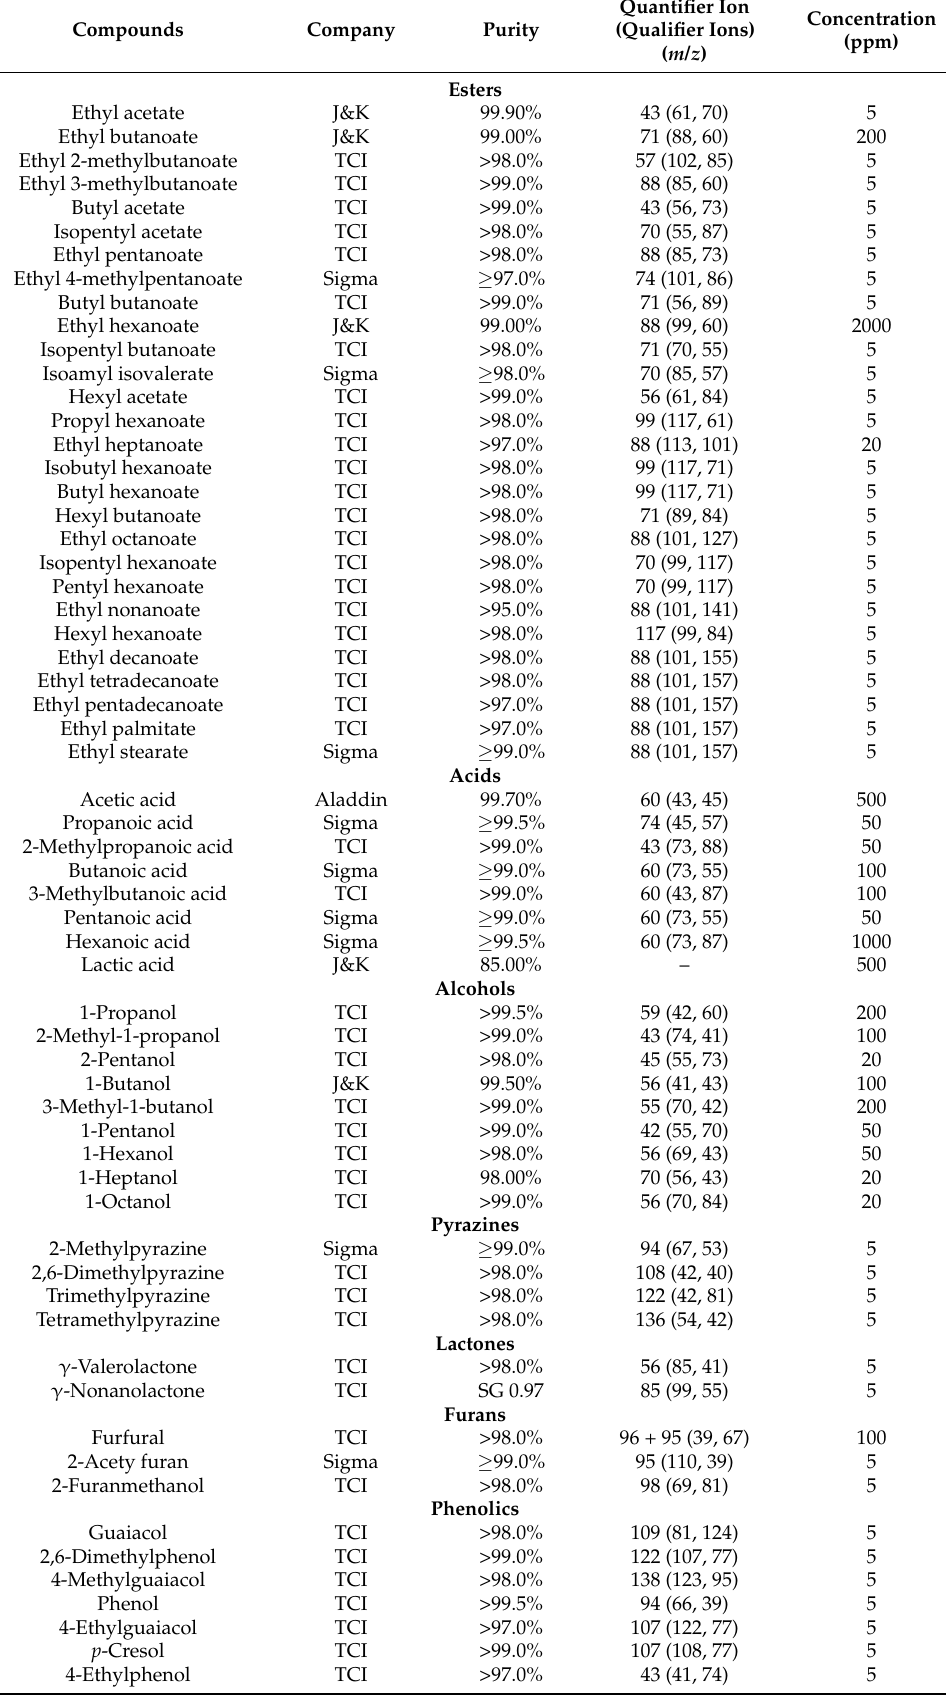
Table 5. Concentration of volatile compounds used for baijiu